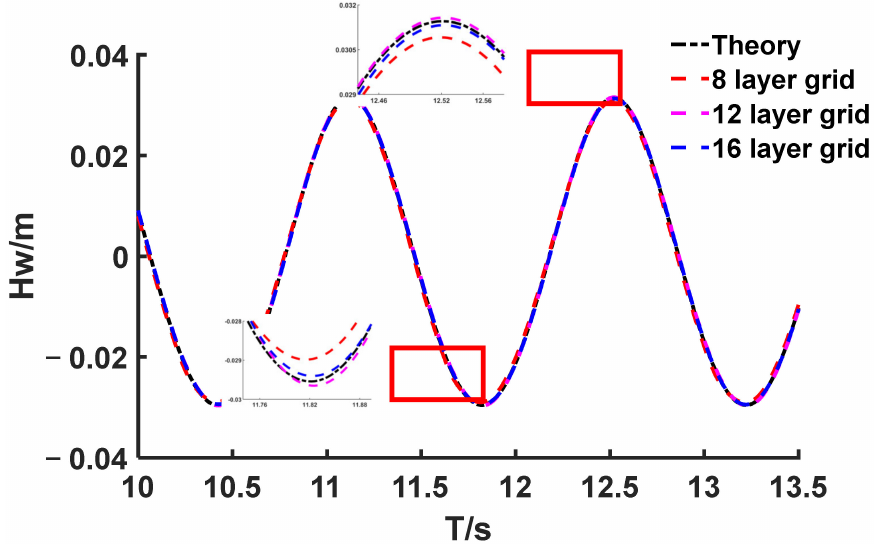
Figure 5. Time histories of wave elevations obtained by the numerical simulation and theory ( T w = 1.4 s).